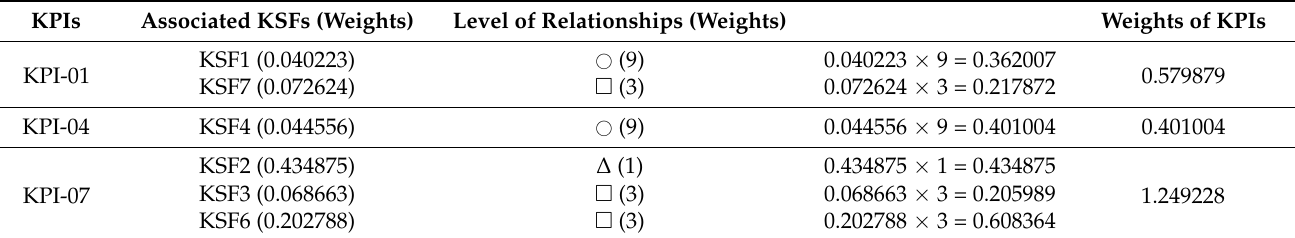
Table 6. Partial results and calculation details of KPI